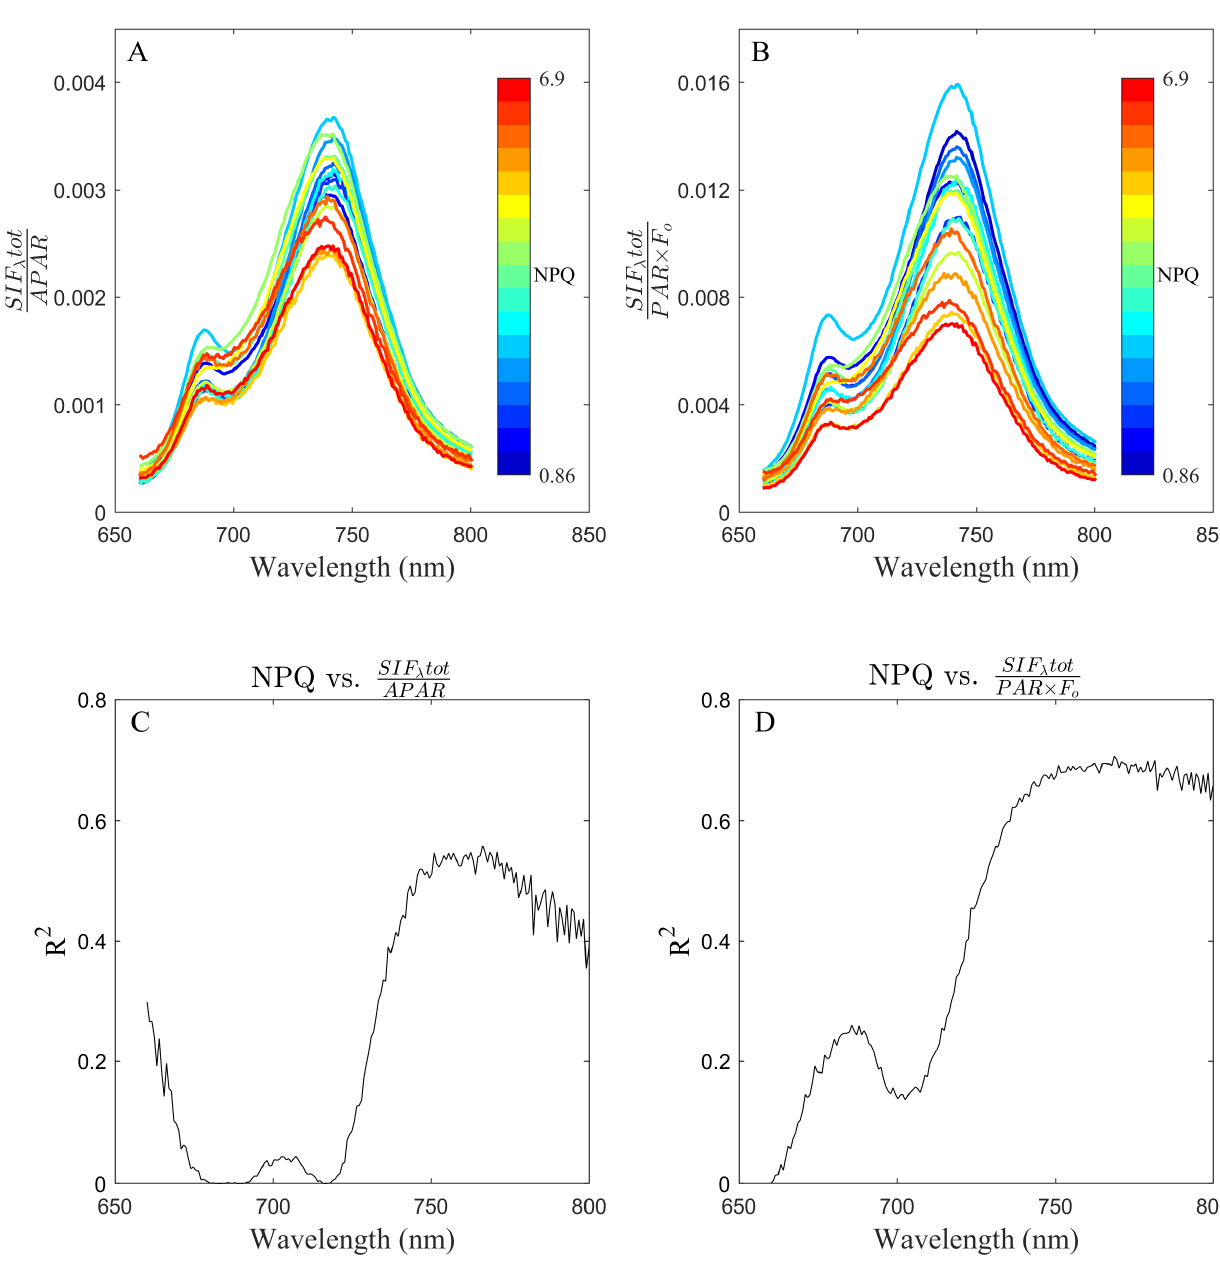
Figure 3. ( A , B ) Two forms of total SIF yield SIF λ tot samples; colored lines represent the nonphotochemical quenching (NPQ) observed in each leaf. ( C , D ) Coefficient of determination ( R 2 ) for all wavelengths of SIF yield against NPQ. The coefficient of determination represents the performance of the linear regression.